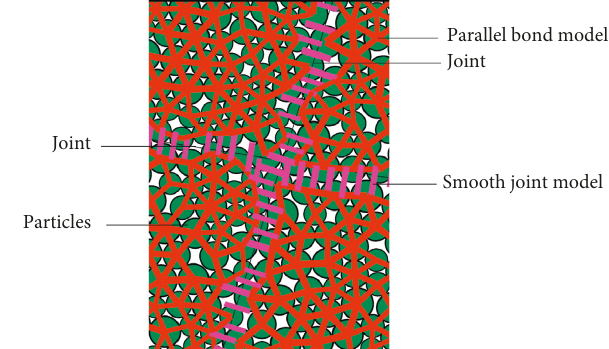
Figure 5: Isomorphic structure of joints and their poles.